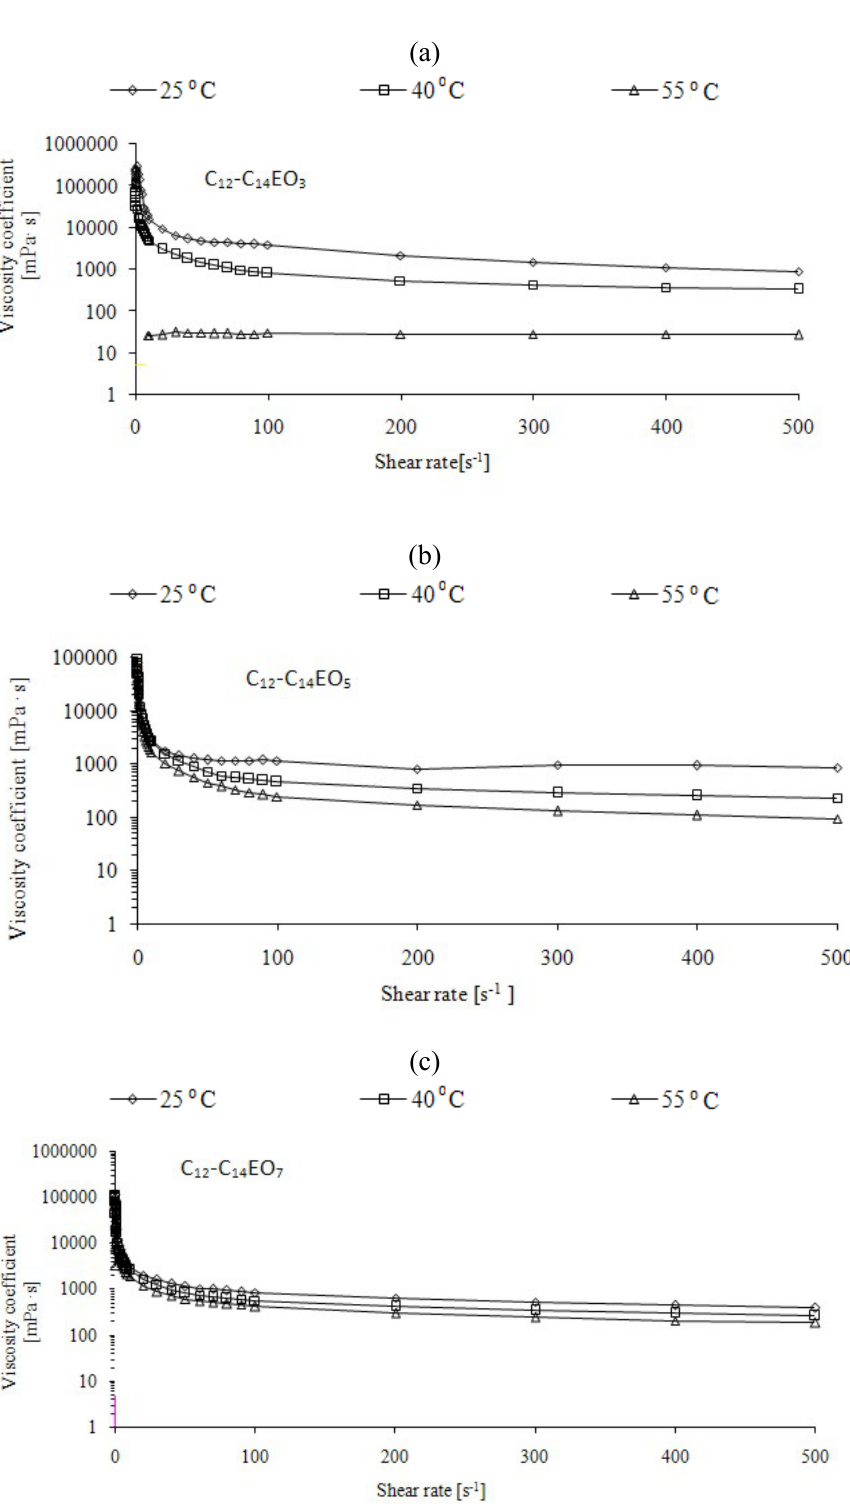
Figure 4. Dynamic viscosity ( η ( ν )) of aqueous solutions of ethoxylated fatty alcohols. Brookfield HADV-III Ultra viscometer, CPE-52 spindle, shear rate 0.02 ÷ 500 s -1 , temperatures of the measurements 25, 40 and 55